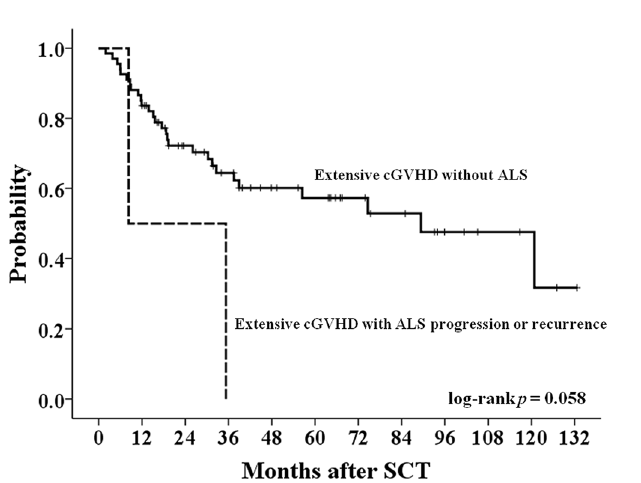
(46%) compared to those without thoracic ALS (Table 1). In multivariate analysis, we further confirmed grade III–IV aGVHD and extensive cGVHD as independent significant risk factors. It has also been reported that pulmonary cGVHD is a significant risk factor for LONIPCs 24,29,30 . In our study, chronic pulmonary GVHD had a significant association with thoracic ALS. We also found that three out of six thoracic ALS patients with pul- monary cGVHD (50%) developed BO, BOOP or IP. Although the definite pathobiological mechanism is not well known, host-reactive donor T cells play an important role in chronic inflammation of the lungs, airway fibrosis and subsequent LONIPCs progression 16,31 . In our study, 4 out of 12 late-onset thoracic ALS patients experienced LONIPCs, and all 4 patients with LONIPCs suffered from extensive cGVHD at thoracic ALS (Table 2). Among 350 patients who survived 3 months or more in our study, 21 patients (6%) suffered from LONIPCs, and this value is slightly less than those in the reported articles 29,32,33 . However, patients with thoracic ALS had a significant association with developing LONIPCs. Extensive cGVHD could lead to a strong association between the pro- gression of LONPICs and thoracic ALS. Moreover, pulmonary IFI could cause pulmonary damage and thoracic ALS 34,35 . Studies describing the relationship between pulmonary IFI and thoracic ALS are lacking, especially in patients receiving allogeneic haematopoietic SCT. In our study population, patients with previous pulmonary IFI had a high risk for thoracic ALS. According to the article by Sakai R et al ., the survival of patients with post-transplant thoracic ALS or mixed type thoracic ALS was significantly impaired 16 . The possible pathomechanism of pneumothorax with